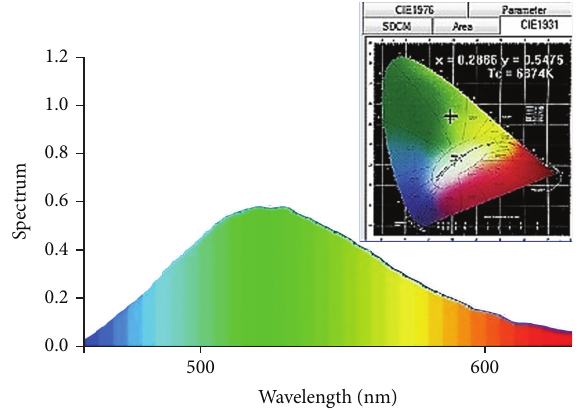
Figure 16: Emission spectrum and CIE-1931 coordinates of fabri- cated